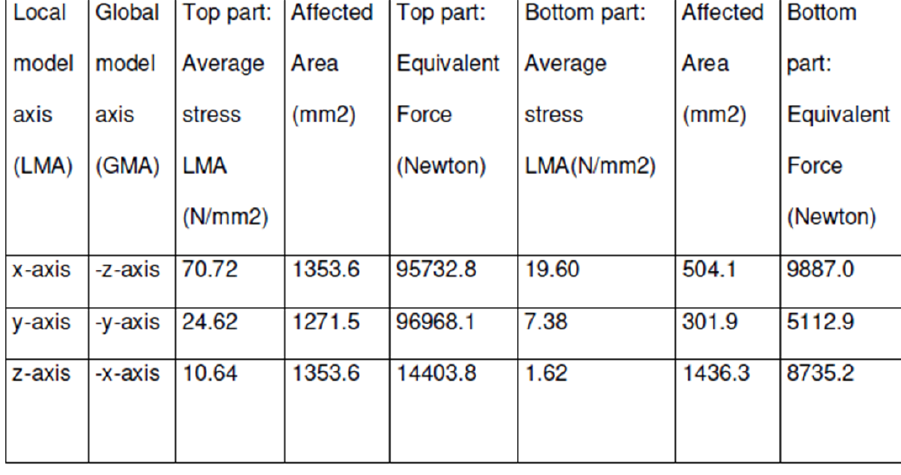
Figure 9. FEA loading table.